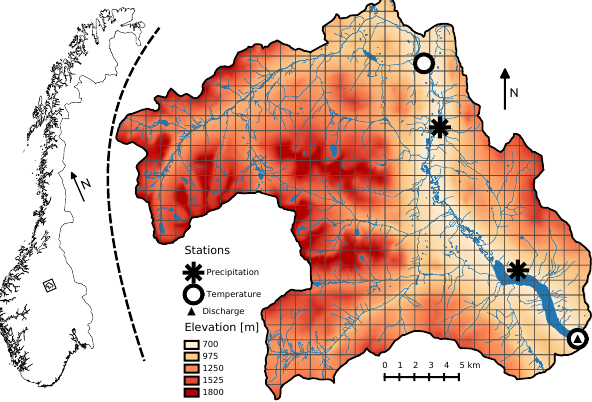
Figure 2. Location of the Atnsjoen catchment in Norway (black box in the left map) and overview map of the Atnsjoen catchment